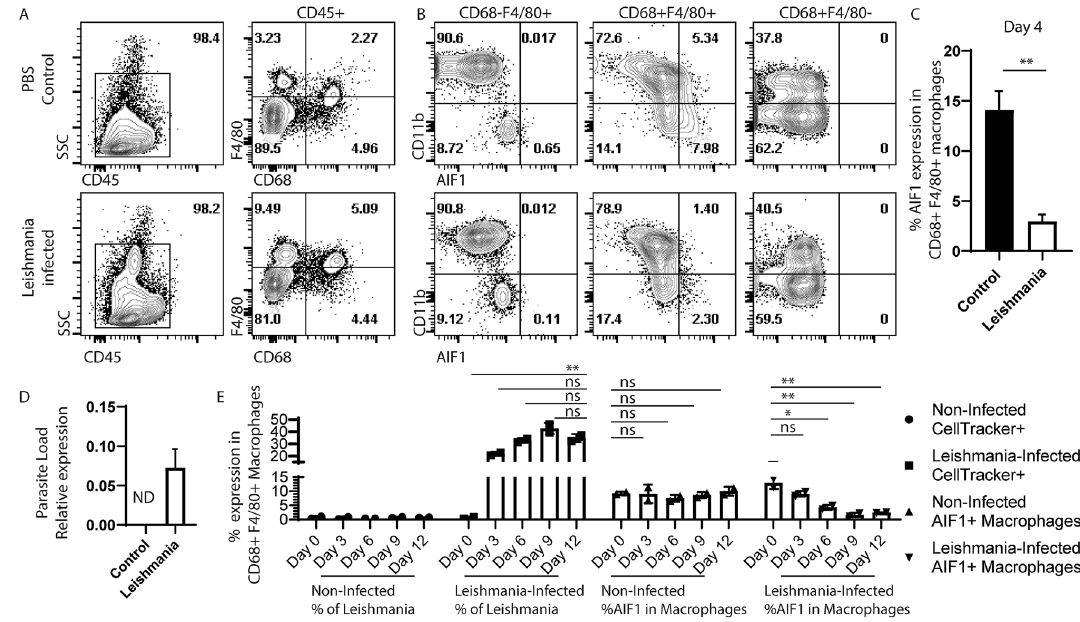
Figure 2. Leishmania infection correlates with lower number of AIF1 + macrophages in the spleen. C57BL/6 mice ( n = 9) were intravenous injected with 10 6 Leishmania donovani promastigotes. Control mice ( n = 9) received PBS. 7 days after injection, spleen was collected from respective groups, each dissociated into single cell suspension and stained for flow cytometry. ( A ) Singlets were gated on CD45 + subsets to assess for F4/80 versus CD68 expression. ( B ) CD11b and AIF1 co-expression were assessed within each quadrant of the F4/80 versus CD68 populations in non-infected control versus Leishmania donovani infected groups. All gates were established using isotype controls. ( C ) Percentage of AIF1 + in the F4/80 + CD68 + subsets is presented as a bar graph. ( D ) Parasite load within the spleen in control versus Leishmania donovani infected groups was measured by qPCR 7 days post-infection. Data shown as mean ± SEM representative of 3 independent experiments with 3 mice per group. ( E ) CellTracker-labeled Leishmania donovani parasites were injected into C57BL/6 mice (n = 10) and used to monitor frequency of infected macrophages every 3 days for 2 weeks. Control mice (n = 10) received PBS. Percentage of Leishmania donovani is determined by looking at frequency of CellTracker + within CD11b +/ neg F4/80 + CD68 + macrophages of non-infected versus infected groups. Percentage of AIF1 + in CD11b +/neg F4/80 + / CD68 + macrophages was concomitantly determined in non-infected versus infected groups. Data shown as mean ± SEM representative of 2 independent experiments with 2 mice per group. Statistical significance was determined by unpaired t -test. * p < 0.05, ** p < 0.01 and ns = not